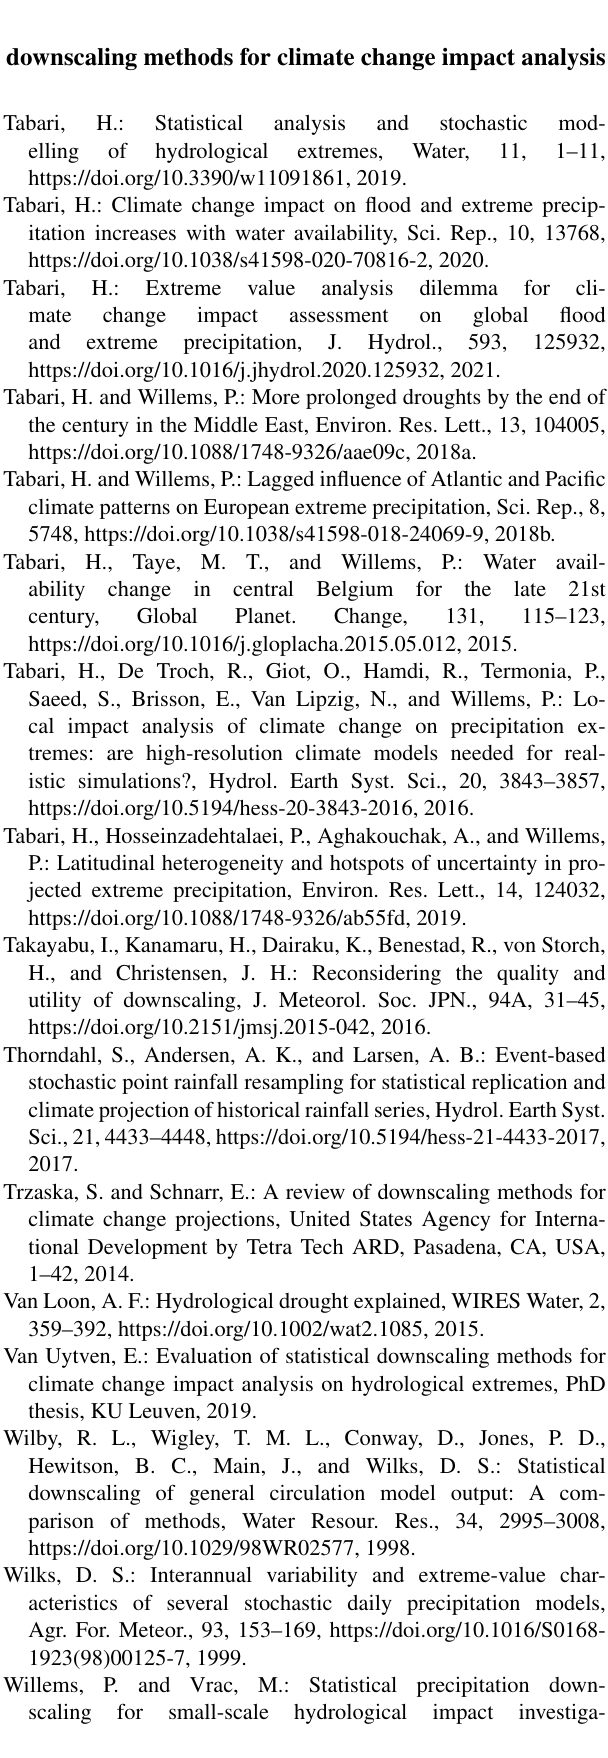
Tabari, H.: Climate change impact on flood and extreme precip- itation increases with water availability, Sci. Rep., 10, 13768, Tabari, H.: Extreme value